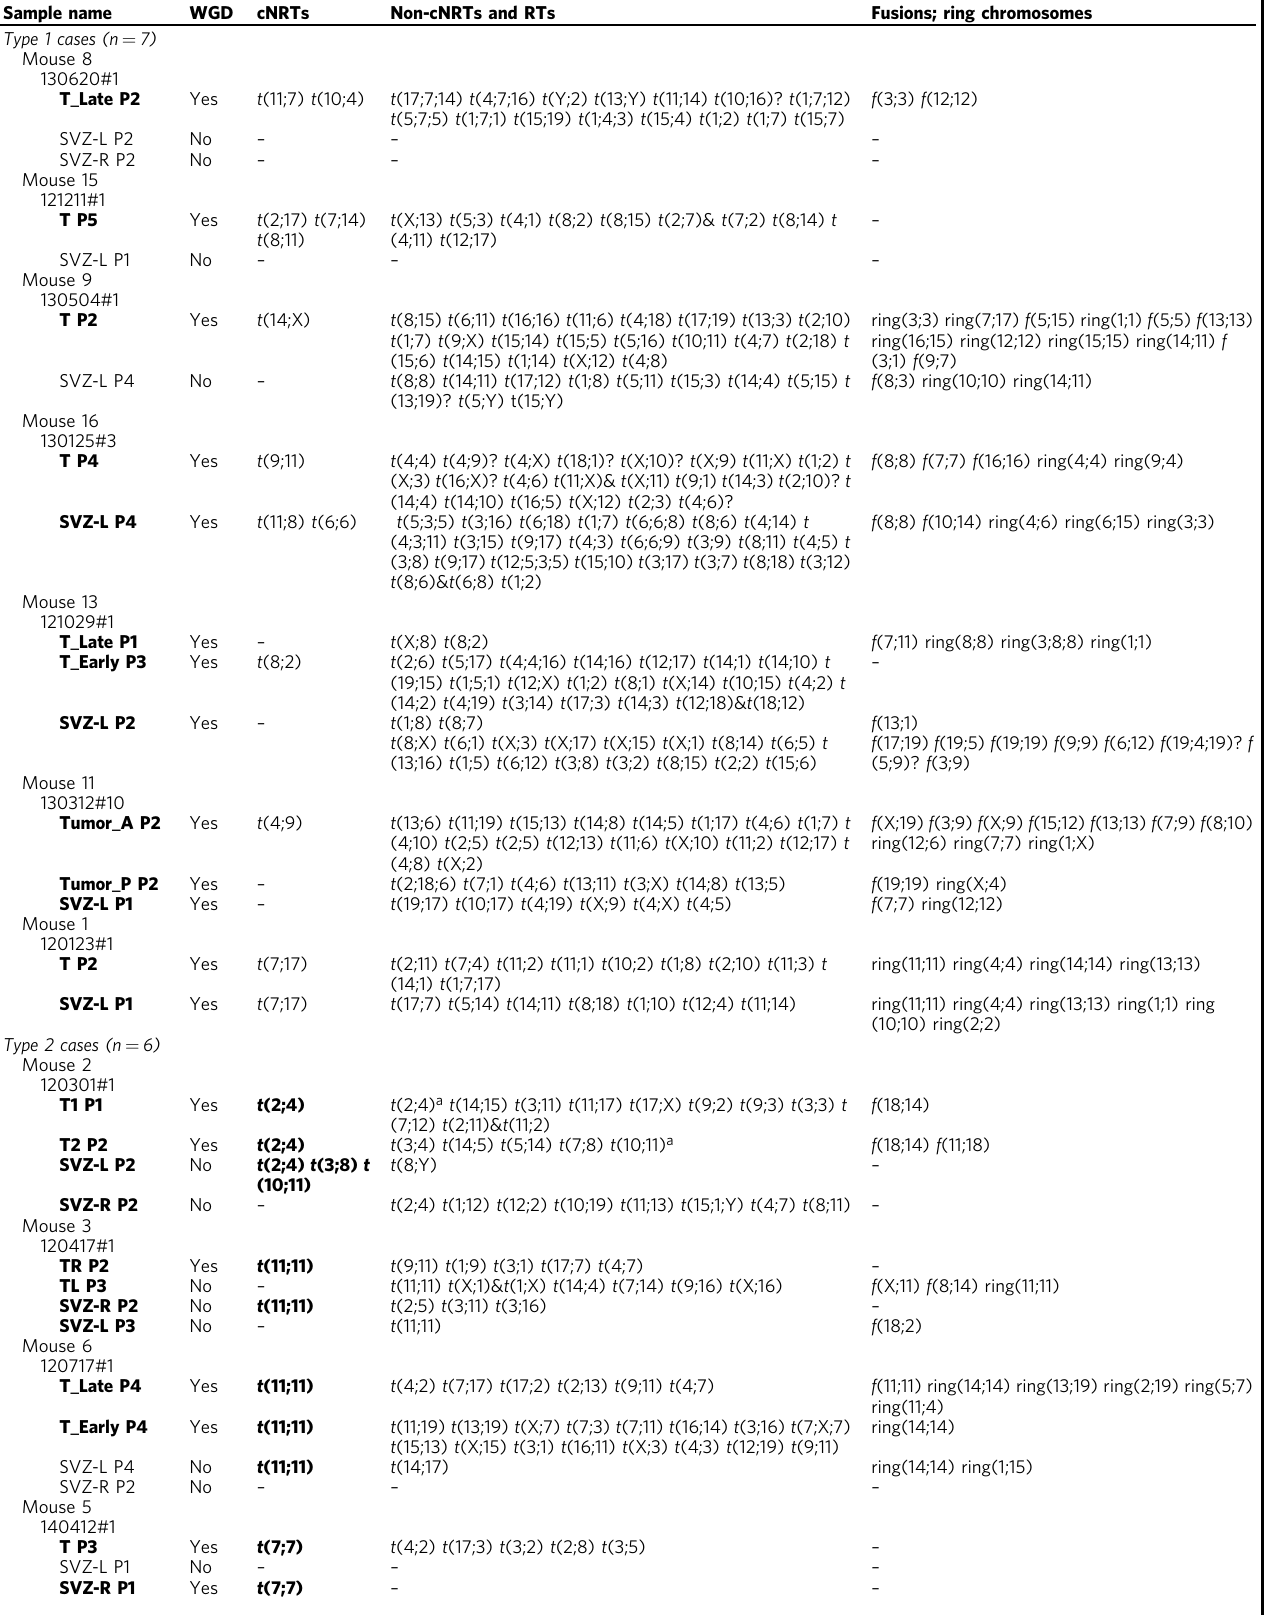
Table 1 Overview of SKY results of parenchymal tumors and SVZ samples from seven Type 1 and six Type 2 cases from p53 R172H CKO